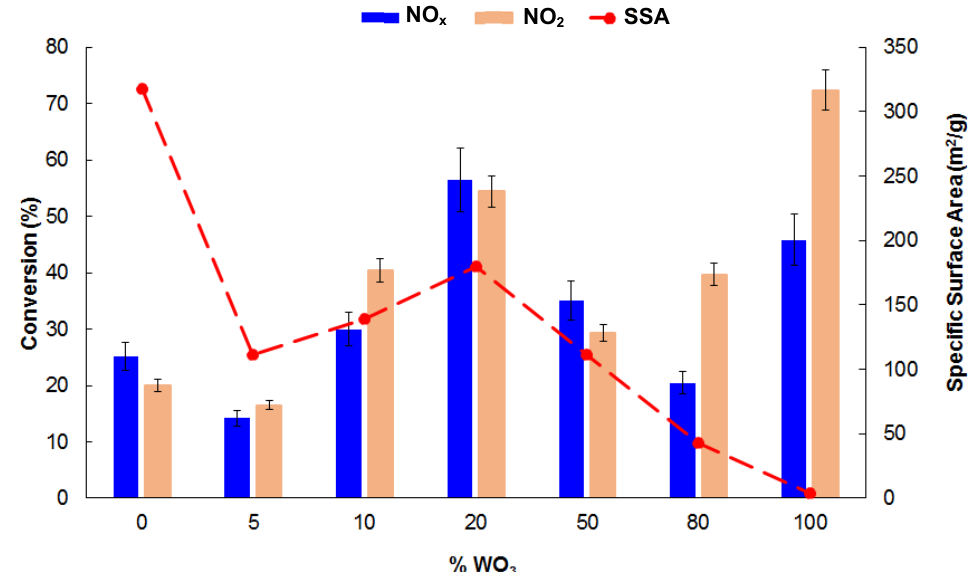
Figure 8. Dependence of NO x and NO 2 photodegradation on WO 3 content and specific surface area (SSA) of the materials.